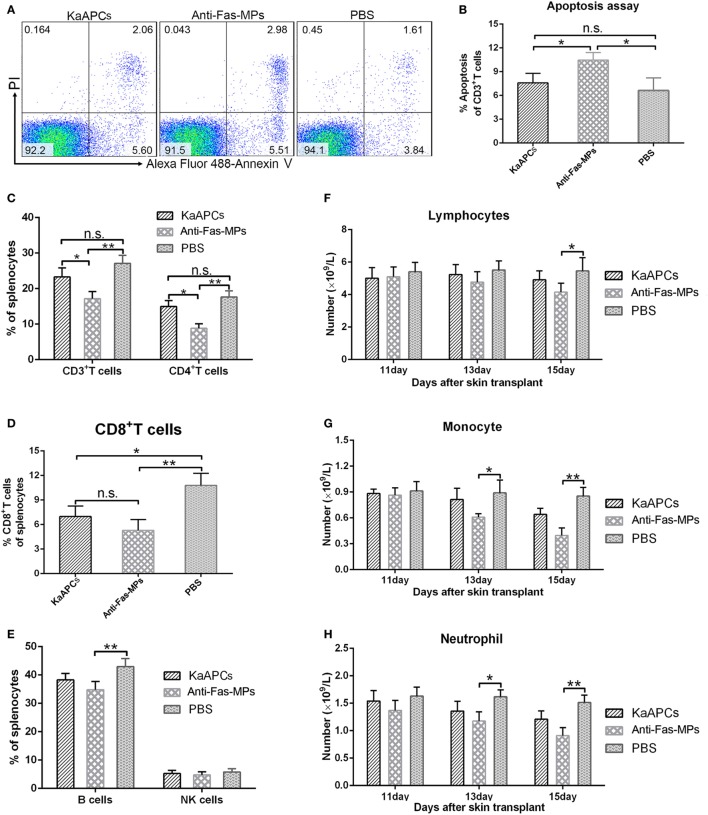
Killer artificial antigen-presenting cells (KaAPCs) do not produce obvious bystander killing to immune cells. After treatment with KaAPCs, anti-Fas-MPs, or PBS on days 9, 11, and 13 after transplantation, spleens were harvested on day 15, and peripheral blood was collected on days 11, 13, and 15 from recipients. Apoptosis of T cells was analyzed by Annexin V/PI staining. A variety of immune cells were enumerated by flow cytometry or automated hematology analyzer. The representative dot plots for apoptosis of T cells from spleens in each treatment group were presented (A). KaAPCs treatment did not lead to obviously higher percentage of apoptosis in the T cell populations than the PBS treatment, but the percentage of apoptotic T cells in anti-Fas-MPs group was statistically higher than the KaAPCs group and PBS group (B). In spleen cell suspensions, the percentages of CD3+ and CD4+ T cell populations (C), CD8+ T cell populations (D), and B cell and NK cell populations (E) in each treatment group were presented. In peripheral blood, injections of KaAPCs did not obviously decrease the amounts of lymphocytes (F), monocytes (G), and neutrophils (H) 2 days after each injection. n = 4–6 mice in each group at each time point. *p < 0.05, **p < 0.01.